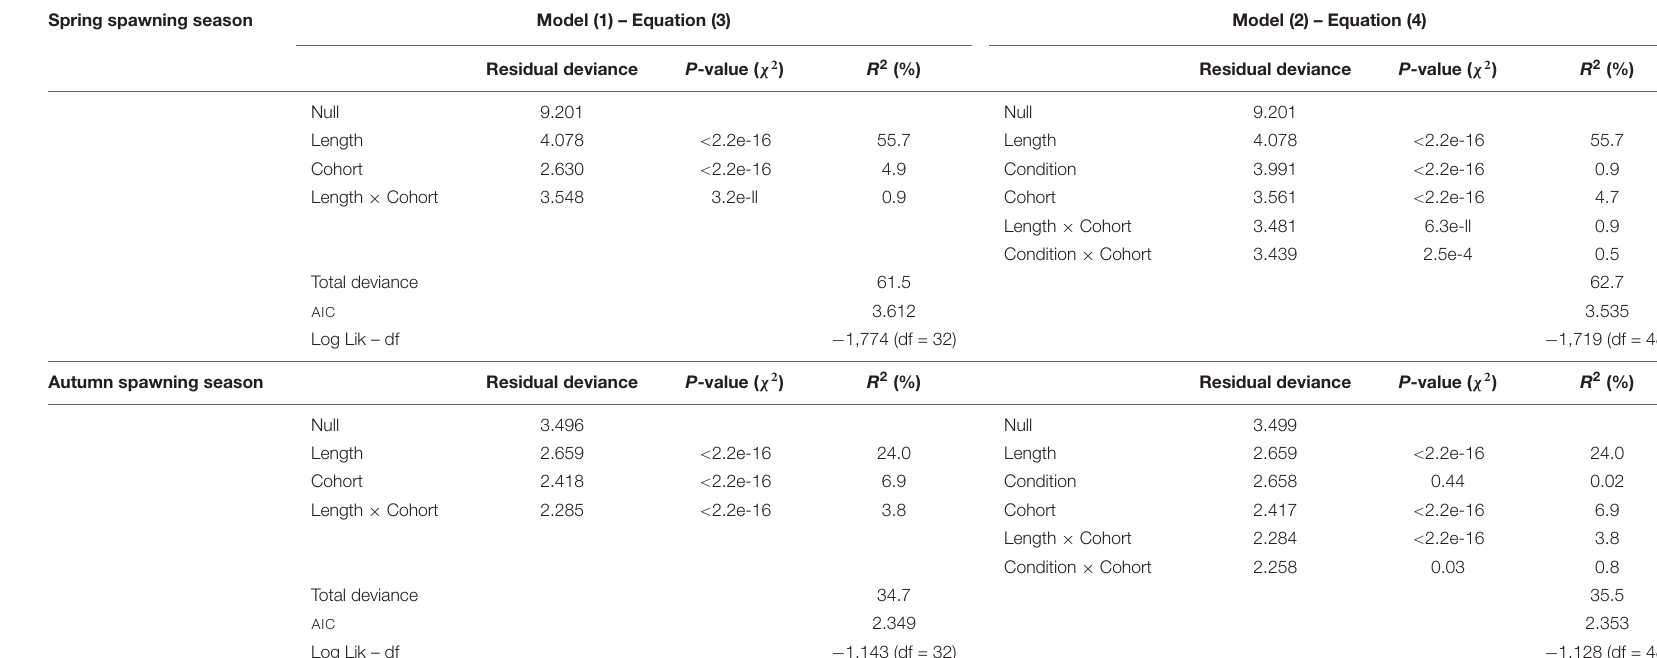
R 2 corresponds to the explained deviance (in %) and AIC is the Akaike Information Criterion. Total explained deviance and log-likelihood (with df) of each model are